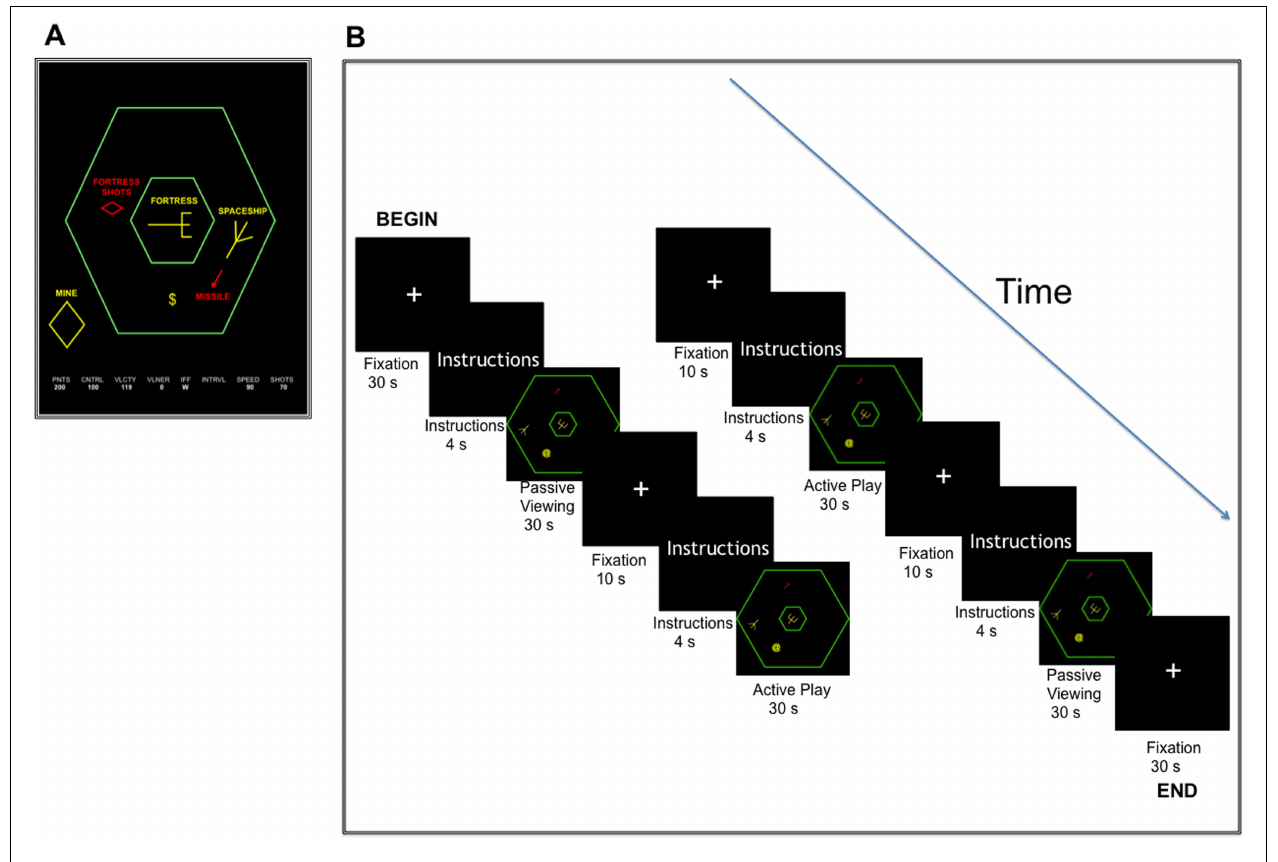
FIGURE 1 | Schematic representation of Space Fortress (A) , along with a graphical description of the SF MRI task design with blocks of active play and passive viewing interspersed with fixation periods (B) .